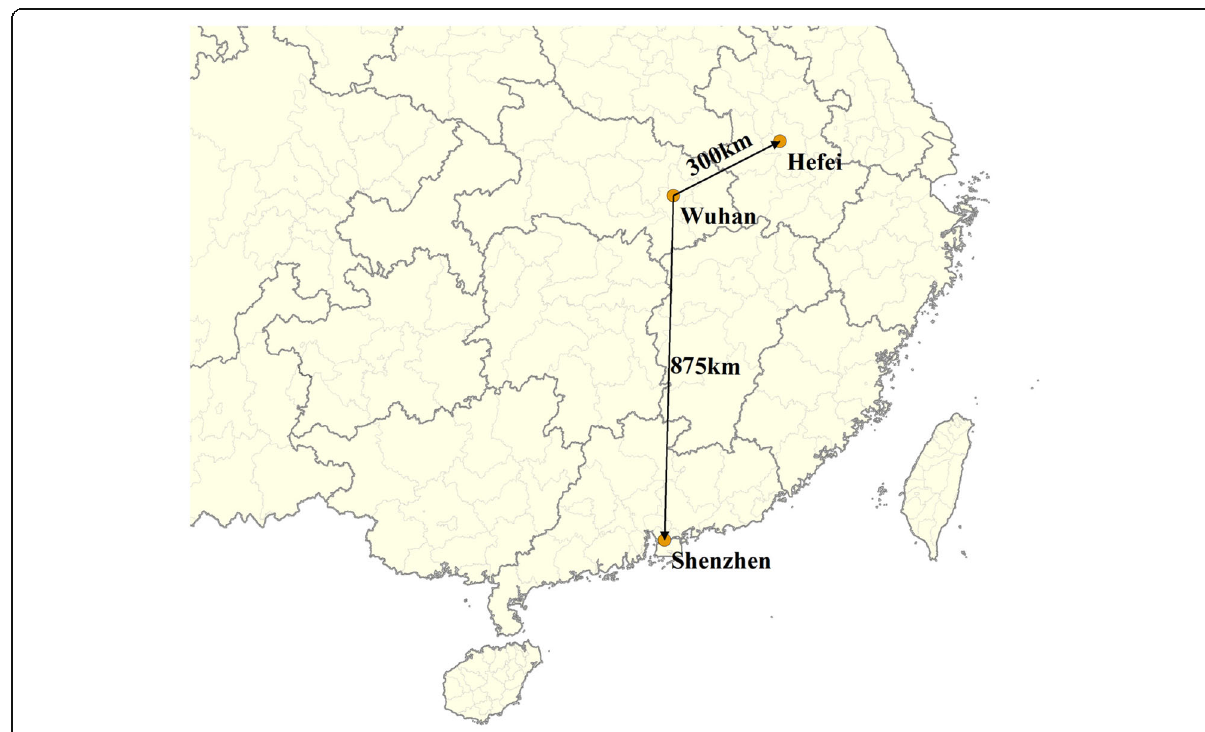
Fig. 1 The locations of Shenzhen and Hefei in